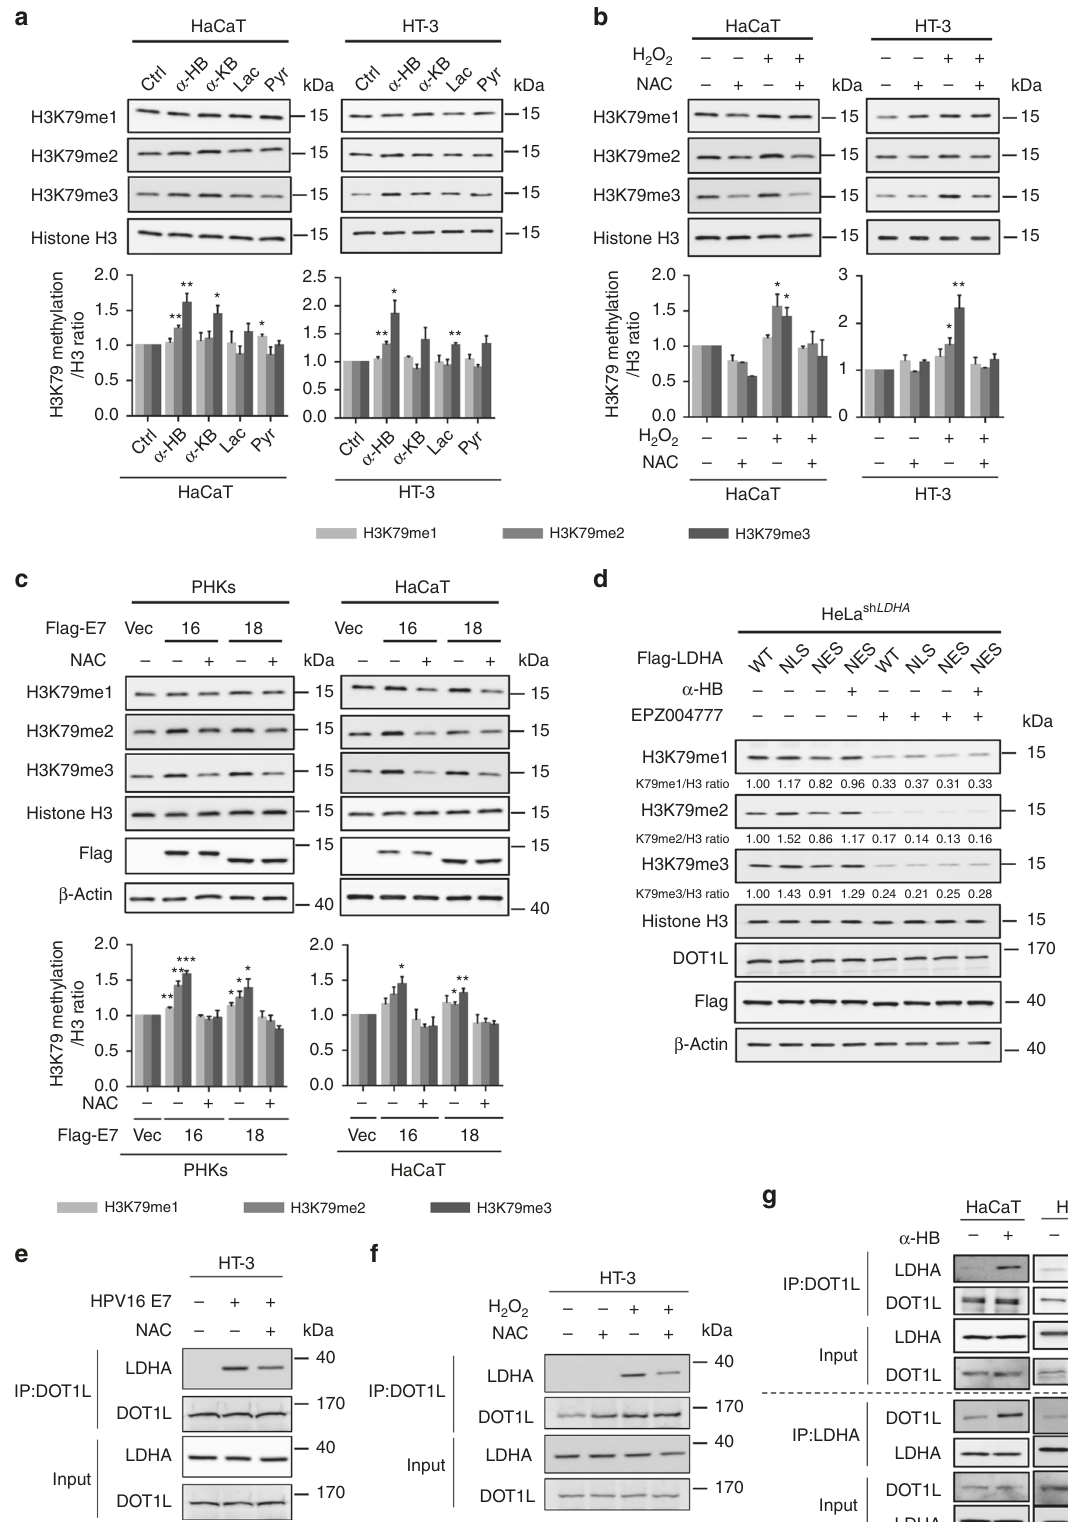
Fig. 10a, b). Furthermore, ChIP-qPCR assays were carried out to de fi ne the histone methylation status of these HPV16/18 E7- induced target genes. We found that HPV16/18 E7 markedly enhanced H3K79 dimethylation level at the SOD1 , CAT , CTNNB1 , and MYC gene body, while NAC supplement